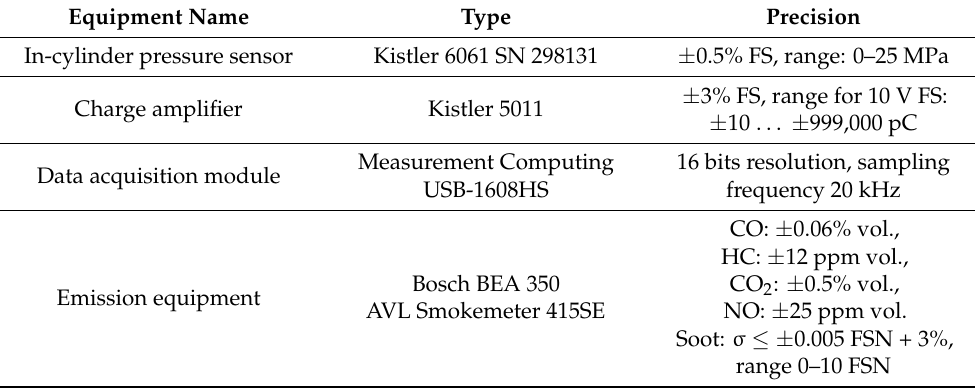
Table 2. The main instruments and equipment of the